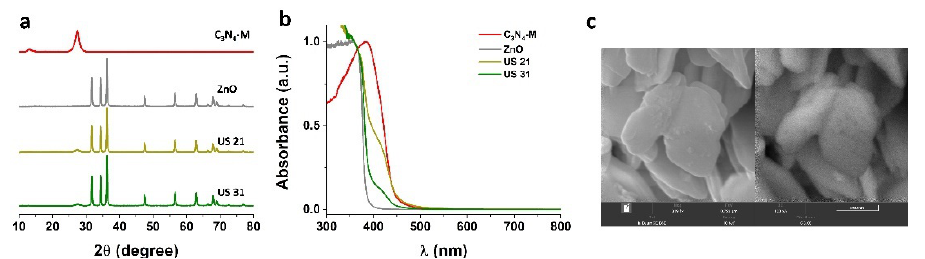
Figure 5. ( a ) XRPD pattern, ( b ) DRS-UV spectra of ZnO, C 3 N 4 -M, US 31 and US 21 samples and ( c ) FESEM images (secondary electrons on the left and backscattered electrons on the right) of the US 31 heterojunction.